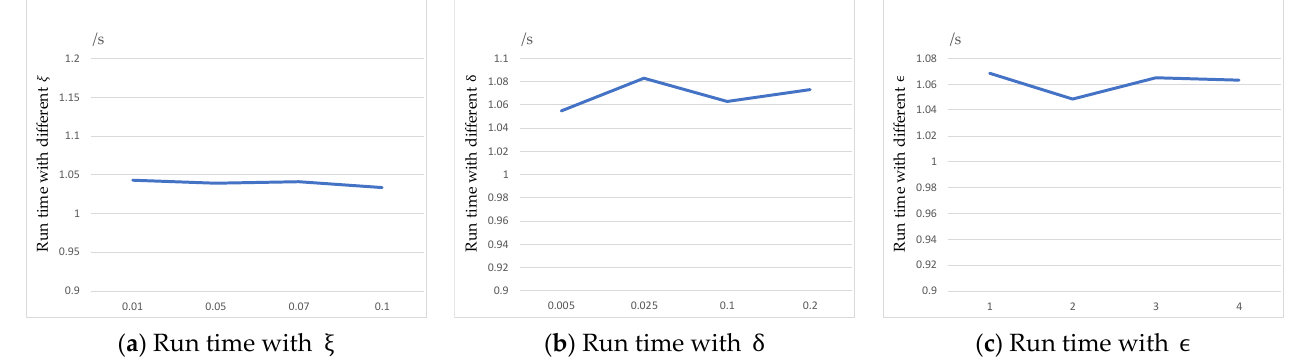
Figure 8. Run time with different parameters.